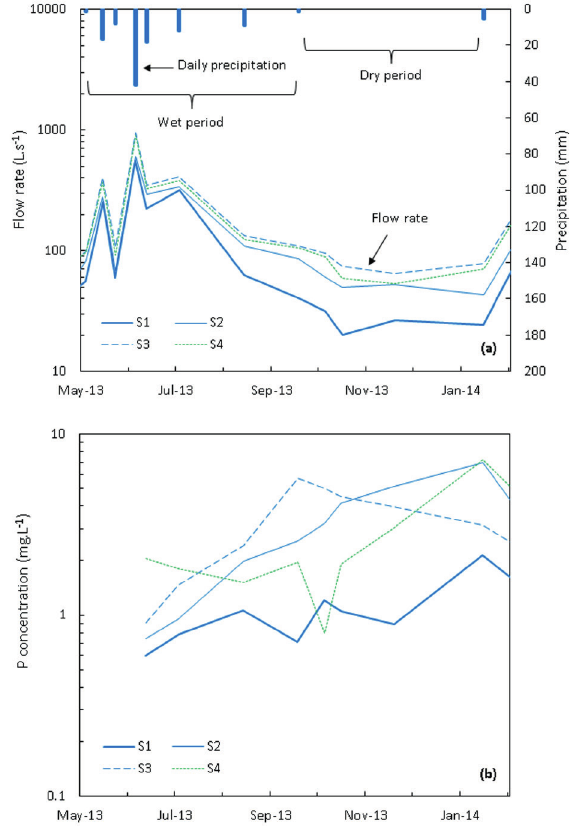
Figure 3 - Seasonal variation of (a) flow rate and (b) total phosphorus concentration measured at different cross-sections S1 – S4 along the channel-reservoir